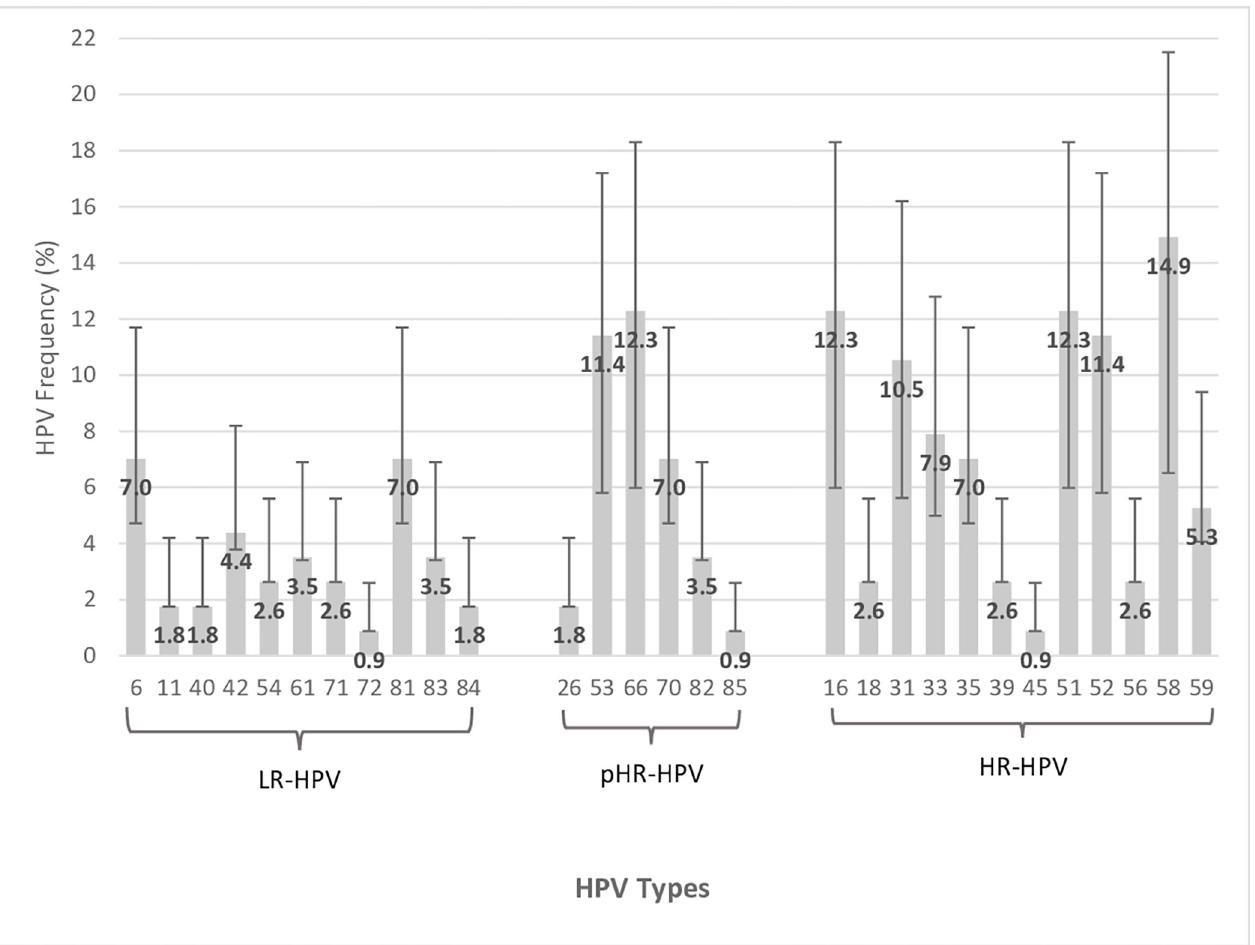
Fig 2. Distribution of viral types among HPV positive genital samples in women with single and multiple infections (N = 208). HR-HPV: High risk HPV types; pHR-HPV: possible high risk; and LR-HPV: low risk HPV types. HR types, including Group 1 IARC, carcinogenic to humans (HPV16, 18, 31, 33, 35, 39, 45, 51, 52, 56, 58, and 59) and Group 2A IARC, probable carcinogenic to humans (HPV68). pHR types, Group 2B IARC, possible carcinogenic to humans (HPV26, 30, 34, 53, 66, 67, 69, 70, 73, 82, 85, and 97). LR types, non-carcinogenic to humans (HPV6, 11, 40, 42, 54, 61, 71, 72, 81, 83, and 84).